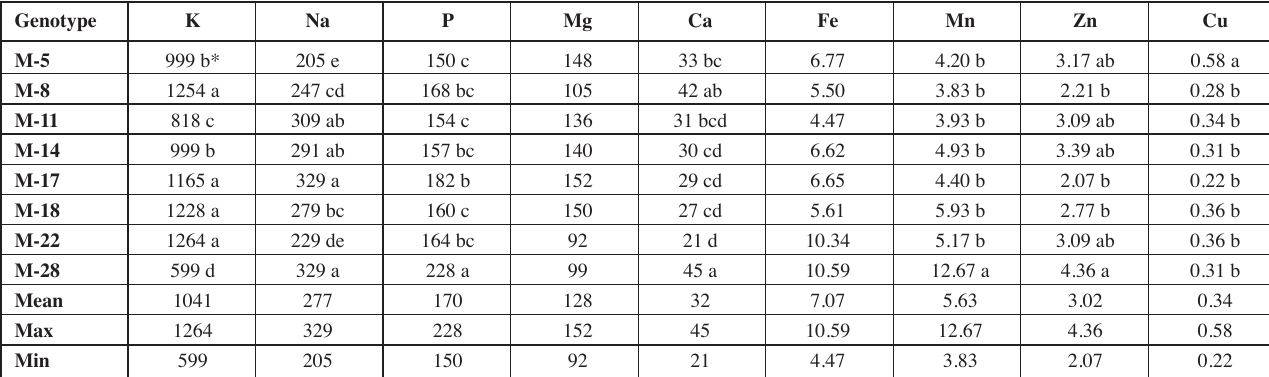
Tab. 2: Mineral composition of black mulberry fruits (mg/100 g). Genotype